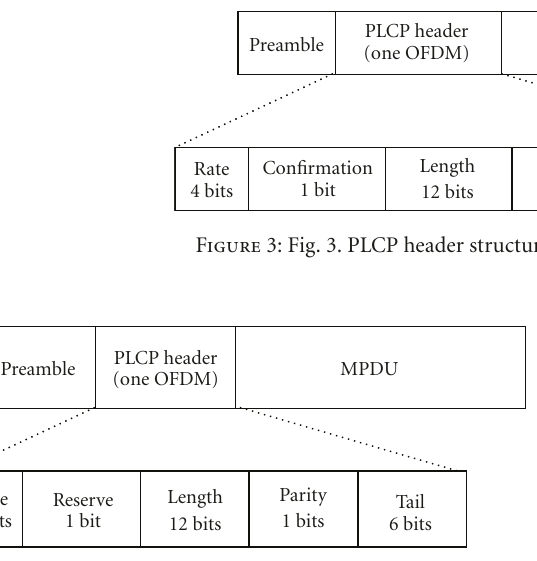
Figure 4: Fig. 4. A conventional RTS packet.